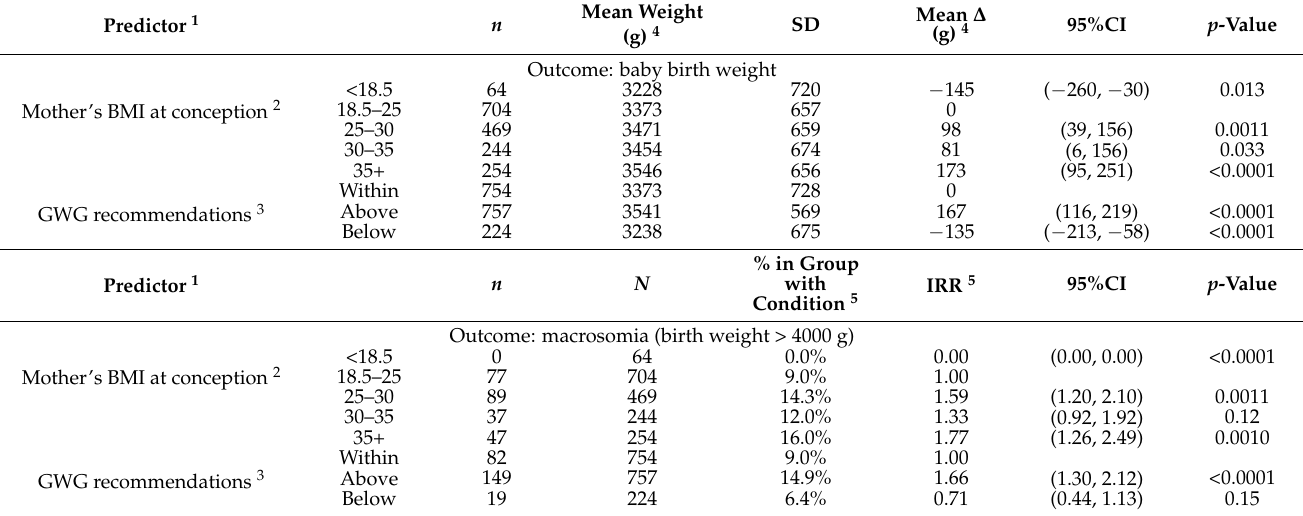
Table 2. Associations between measures of the baby’s birth weight and its mother’s pre-pregnancy BMI and GWG by the time of